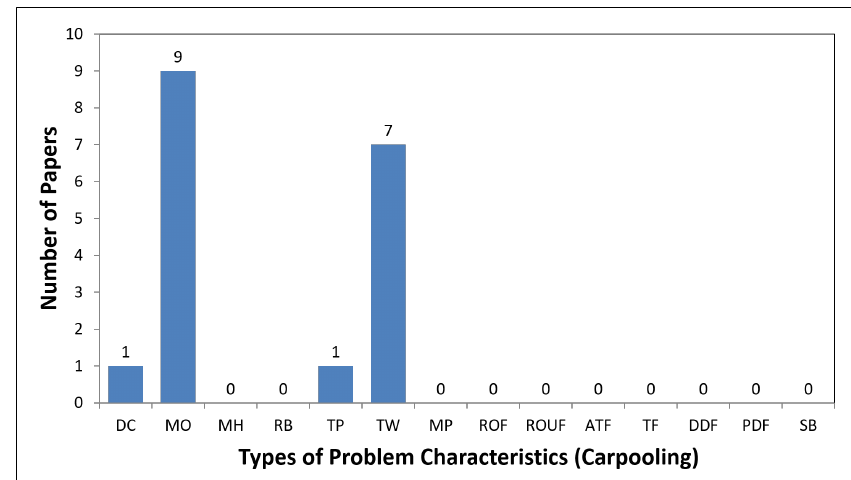
Figure 10. Distribution of Papers based on the Problem Characteristics: Carpooling.